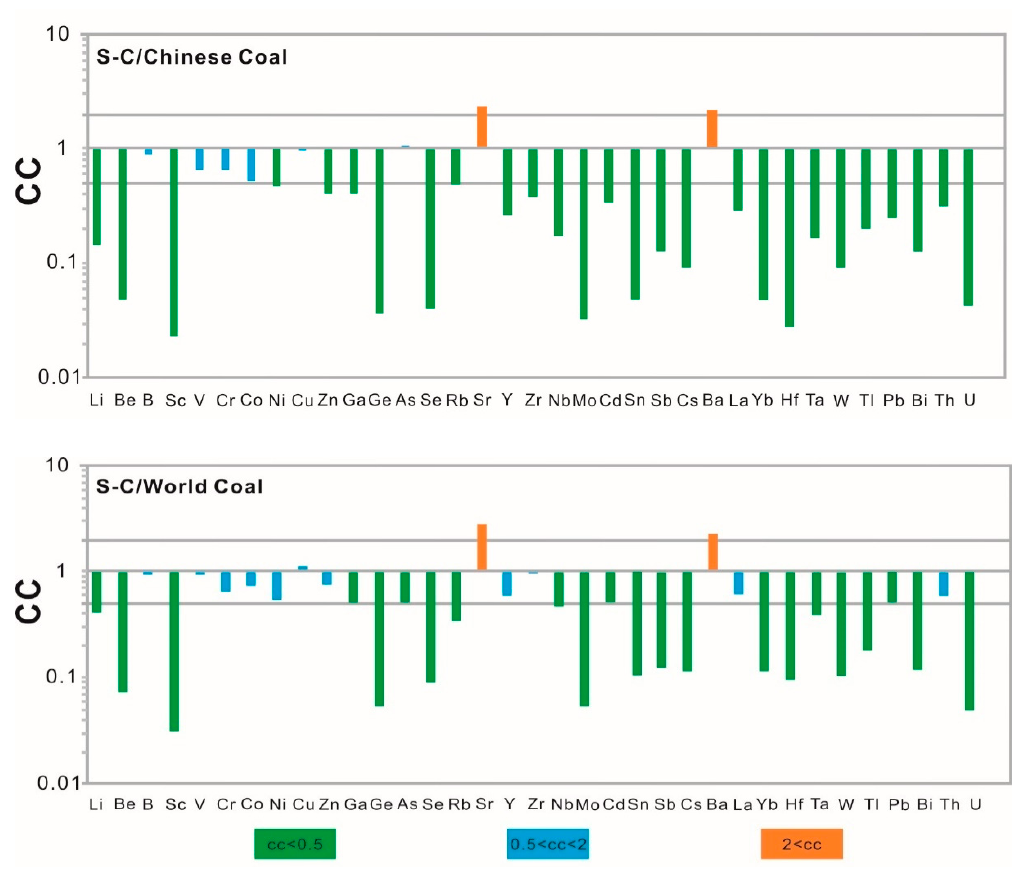
Figure 3. Concentration coefficients of trace elements in feed coal from Shenhuo power plant normalized to corresponding average values in Chinese [50] and worldwide [51] coals (modified after Dai et al., 2015) [29].